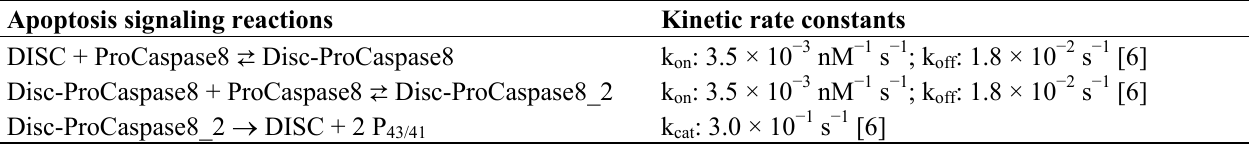
Table A1. Reaction moves considered in our Monte Carlo